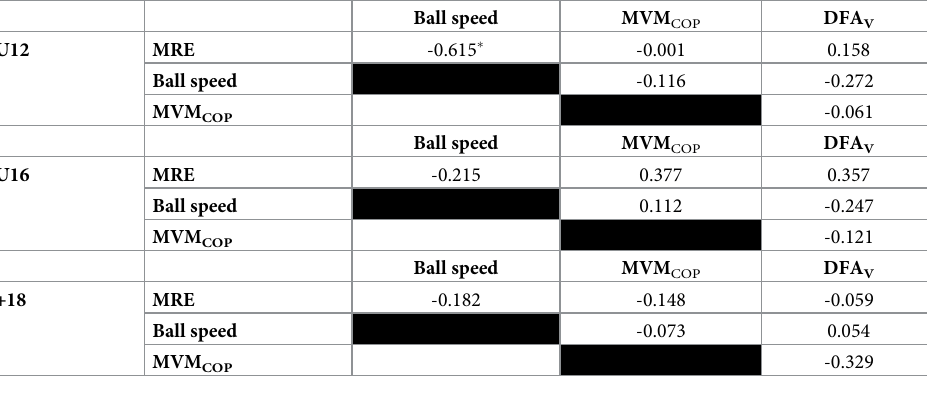
in DFA between expert and recreational players were significant in the +18 group (Fig 2). V Once the differences between age ranges and skill levels were analyzed, Pearson product- moment correlation coefficients were computed to assess the relationship between the serve performance (MRE and ball speed variables) and balance parameters. The correlational analy- sis of the whole sample (Table 2) reflects the main results reflected in ANOVA, showing an inverse relationship between ball speed and MRE (r = -0.611; p < 0.001). There was no relation between balance performance and serve performance but DFA values were related to both V MRE (r = 0.225; p = 0.02) and ball speed (r = -0.255; p = 0.008). Overall, no systematic correla- tion was observed between balance and serve parameters in expert (Table 3) nor in recrea- tional players (Table 4). Only the expert U16 group showed a positive relationship between MVM and serve accuracy (r = 0.461; p = 0.036). COP Table 4. Correlations between all the variables for recreational players.